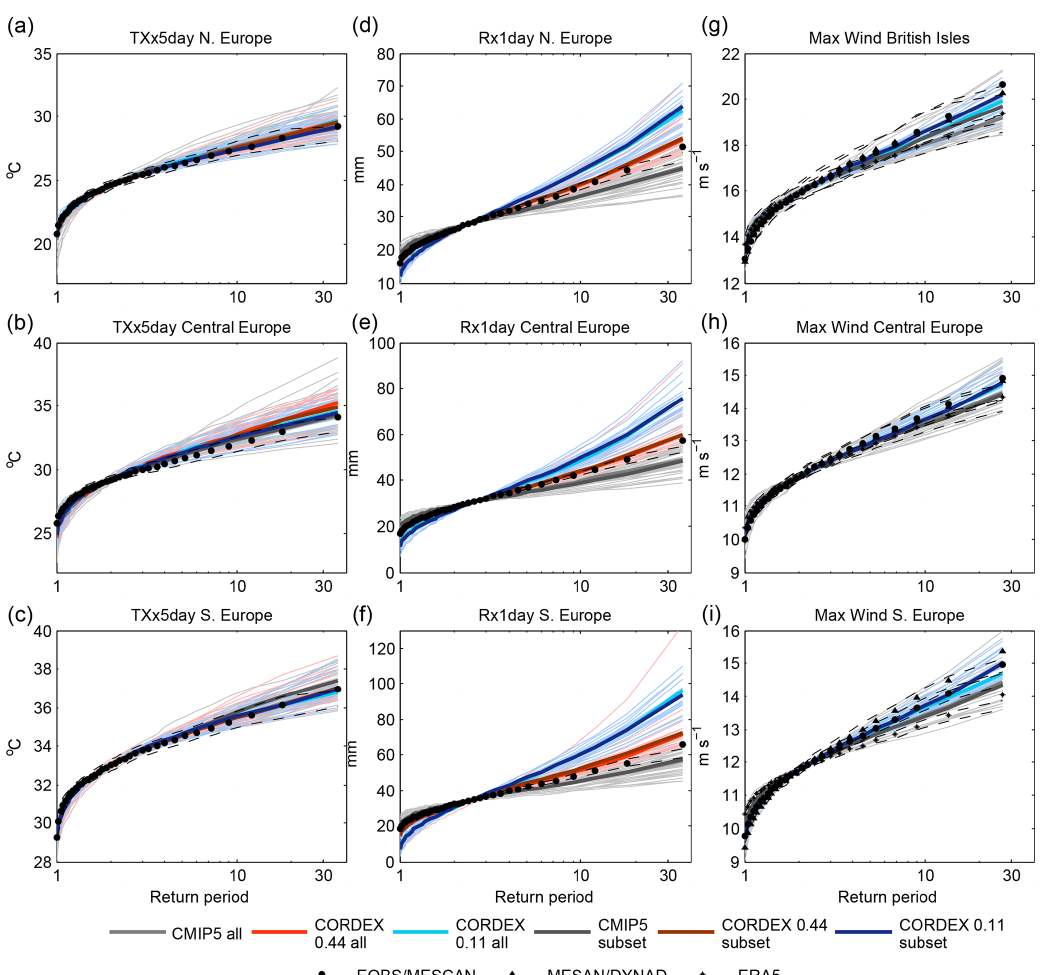
Figure 2. Return period plots for (a, b, c) TXx5day, (d, e, f) Rx1day, and (g, h, i) annual maximum wind for CMIP5 and CORDEX for northern Europe ( a, d ) (except g : British Isles), central Europe (b, e, h) , and southern Europe (c, f, i) . CMIP5 is shown in grey, CORDEX 0.44 ◦ in red, and CORDEX 0.11 ◦ in blue. Thin lines are individual ensemble members, and thick lines are multi-model medians: lighter colours are for the full ensembles, and darker colours are for the subset of models common to CMIP5 and both CORDEX resolutions. Observational datasets are shown in black, circles are for E-OBS temperature and precipitation and MESCAN wind, triangles are for MESAN precipitation and DYNAD wind, and crosses are for ERA5 wind. Confidence intervals based on bootstrapping are shown with dashed lines for the observational datasets. The time periods considered are 1970–2005 for TXx5day and Rx1day and 1979–2005 for